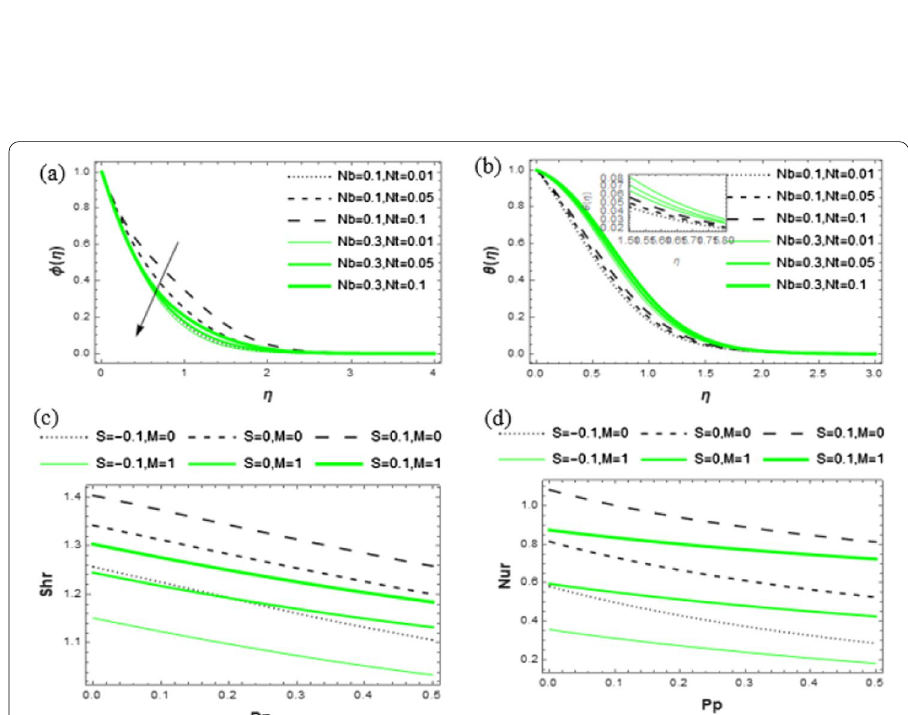
Fig. 7 a , b , c , and d Eckert number, chemical reaction, activation energy parameters, Brownian parameter, and thermophoresis parameter, suction parameter on fluid temperature, concentration profiles, Nusselt number, and Sherwood